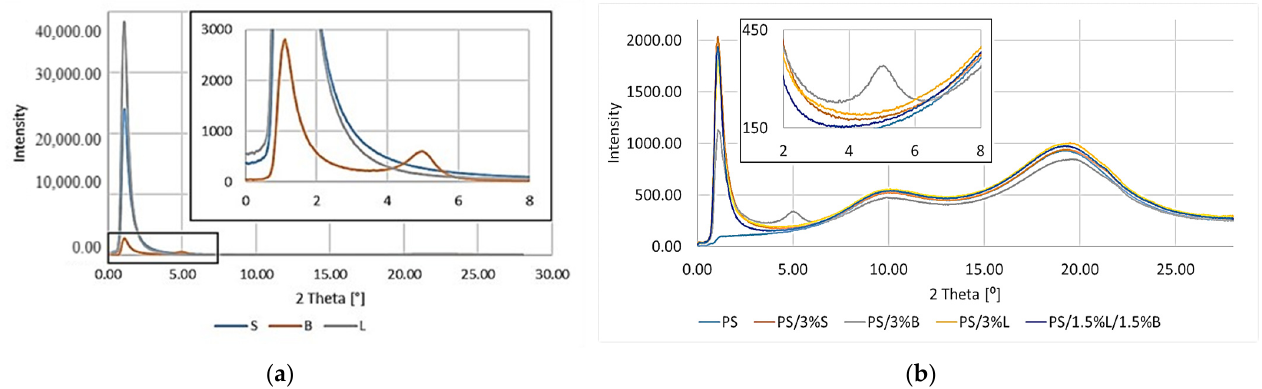
Figure 9. WAXS patterns: ( a ) fillers; ( b ) PS and composites with the addition of modified S, B, and L fillers.